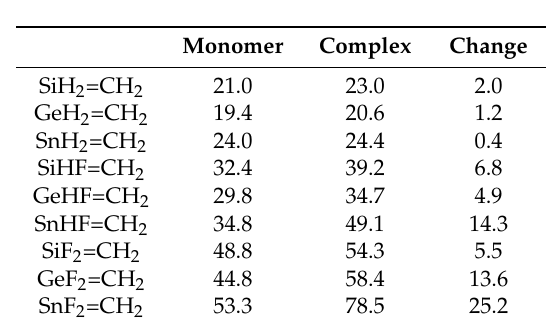
Table 9. Magnitude of V s, max (kcal/mol) on T atom of isolated TR 2 =CH 2 molecule and its value when the molecule is distorted to that within the π -bonded c